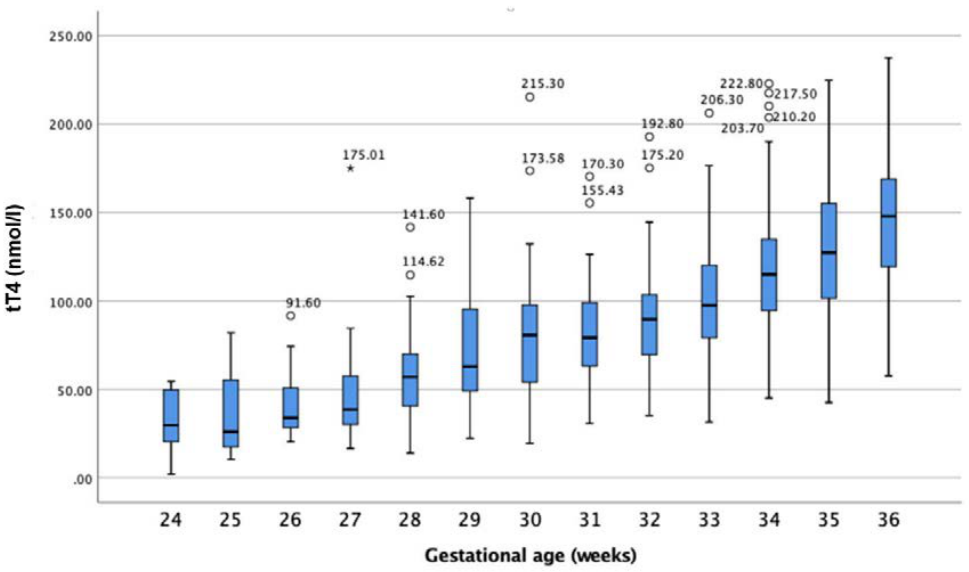
Table 3). Overall, the tT 4 values ranged from under 10 nmol/L in infants born in the 24th week of pregnancy to a maximum of 237.5 nmol/L in infants born in the 36th week of pregnancy.